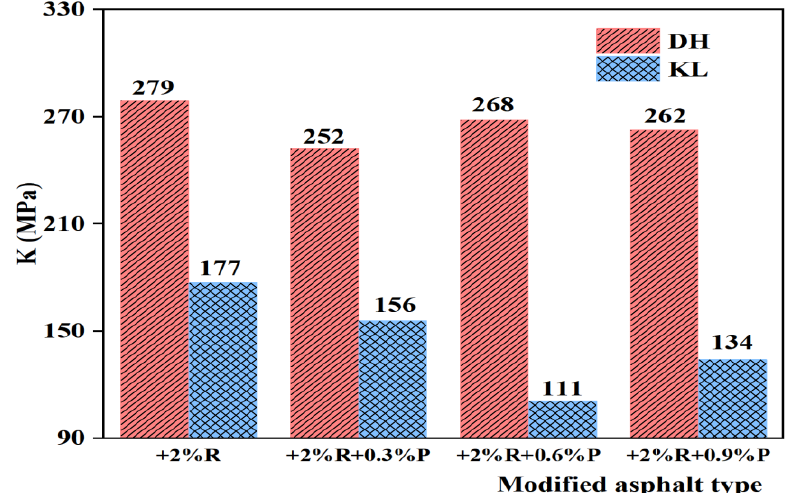
Figure 9. K index of composite modified asphalt with different PPA/SBR dosages.